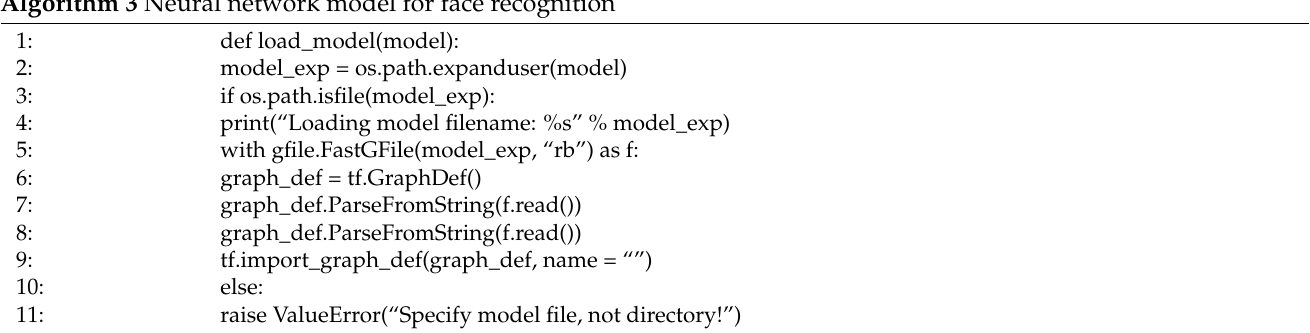
Figure 4. The result is the distance between the object and the camera. These lines (Algorithm 3) load the neural network model that is used as the face recognition algorithm (Algorithm 3). Algorithm 3 Neural network model for face recognition